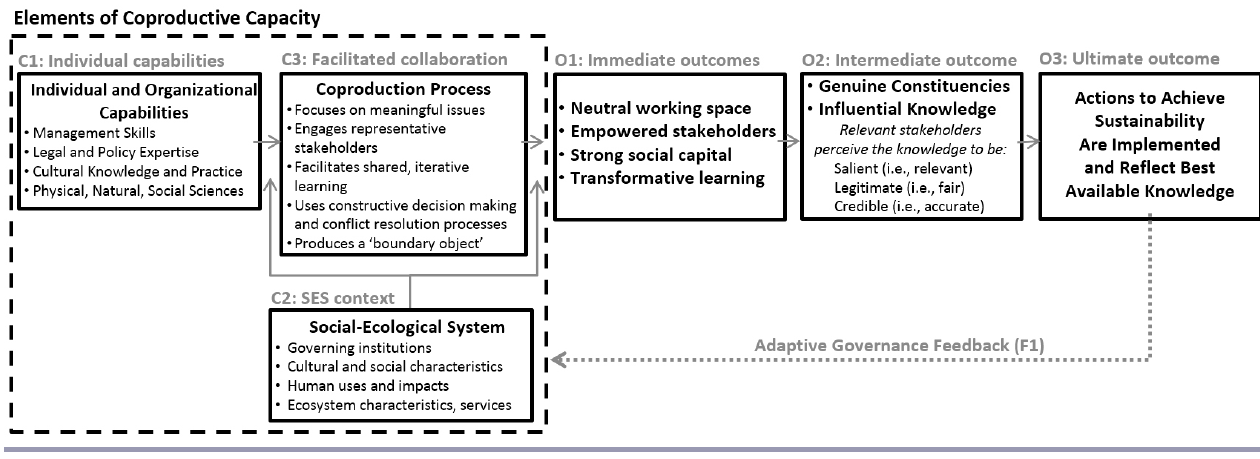
Fig. 1 . Conceptual framework that specifies the sequential goals of knowledge coproduction (identified as O1-O3) and potential sources of coproductive capacity